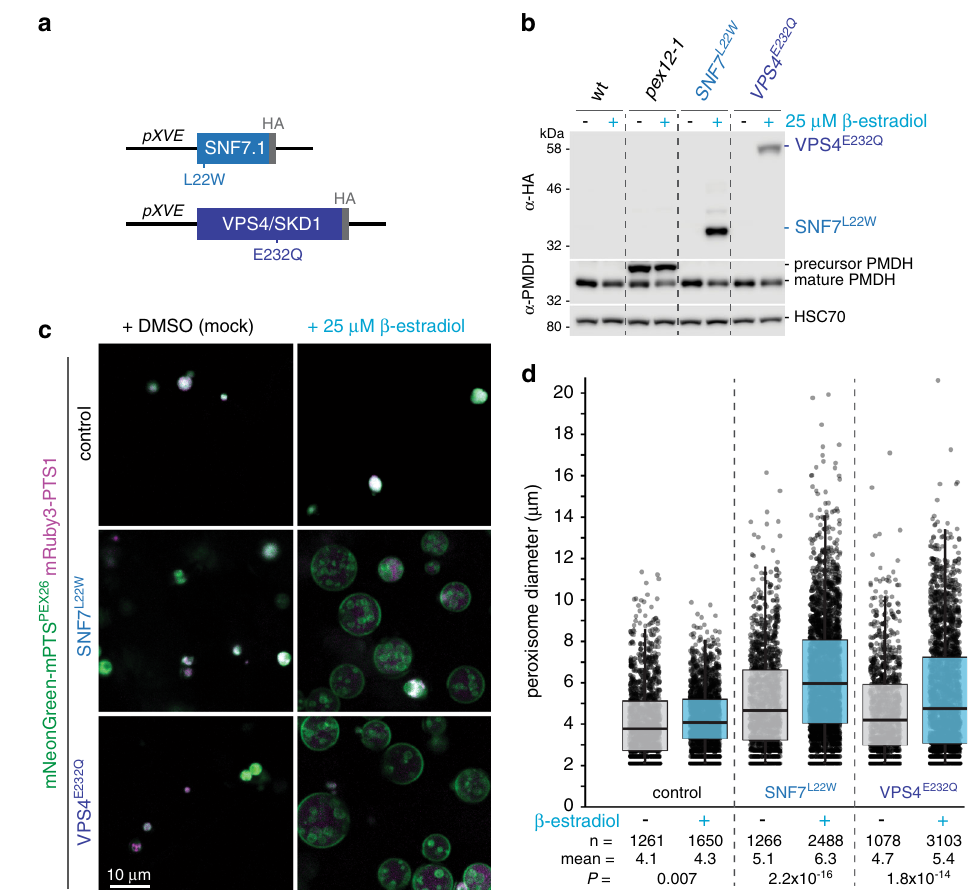
Fig. 3 ESCRT function is required for ef fi cient peroxisomal inner membrane formation. a Diagram of dominant-negative ESCRT constructs driven by the β -estradiol-inducible pXVE promoter system 18 . b Dominant-negative ESCRT derivatives exhibit estradiol-dependent accumulation and do not impair peroxisomal protein processing. Immunoblots of 5-day-old seedlings grown without or with 25 µ M β -estradiol are shown. The PTS2 signal region of the PMDH precursor is cleaved from mature PMDH in the peroxisome lumen. Precursor accumulation in the pex12-1 mutant 79 re fl ects protein import defects. c ESCRT disruption impairs peroxisomal ILV formation. Cotyledon epidermal cells are shown of 5-day-old seedlings expressing mNeonGreen-mPTS PEX26 (green) and mRuby3-PTS1 (magenta) and lacking (control) or carrying constructs expressing dominant-negative SNF7 L22W or VPS4 E232Q grown with DMSO (mock) or β -estradiol. d ESCRT disruption causes enlarged peroxisomes. Peroxisome diameter was quanti fi ed from images of four seedlings (Supplementary Fig. 2) expressing mNeonGreen-mPTS PEX26 and mRuby3-PTS1 and grown without (gray) or with (blue) 25 µ M β -estradiol to induce SNF7 L22W or VPS4 E232Q expression. Boxes show second and third quartiles, horizontal lines are medians, and whiskers encompass data points up to 1.5 times the interquartile range past the box ends. Student ’ s two-tailed unpaired t tests were used to compare peroxisome size with and without β